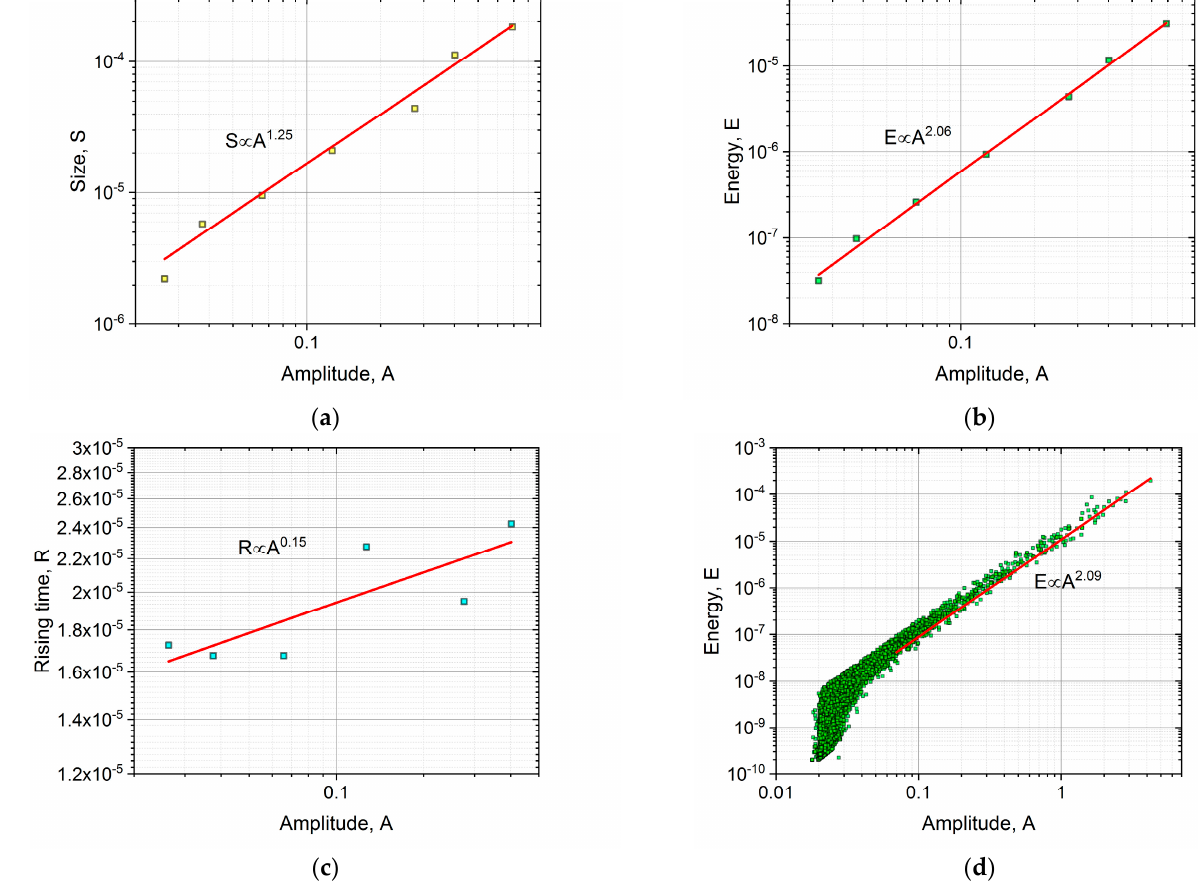
Figure 2. Relations between the parameters of the averaged avalanche profiles, ( a ): S ∝ A 2 − ϕ , ( b ): E ∝ A 3 − ϕ , and ( c ): R ∝ A 1 − ϕ . The ϕ values from the fittings of ( a , b ) are 0.75 ± 0.03 and 0.94 ± 0.02, respectively. The final value, ϕ = 0.85, was determined as the average value of these two fittings, since the rising time has high uncertainty. The red line in ( c ) indicates the expected slope, using ϕ = 0.85. For comparison, ( d ) shows the relation between the energy and amplitude of the individual avalanches, resulting 𝜑 = 0.91, which is close to the value determined from ( b ).